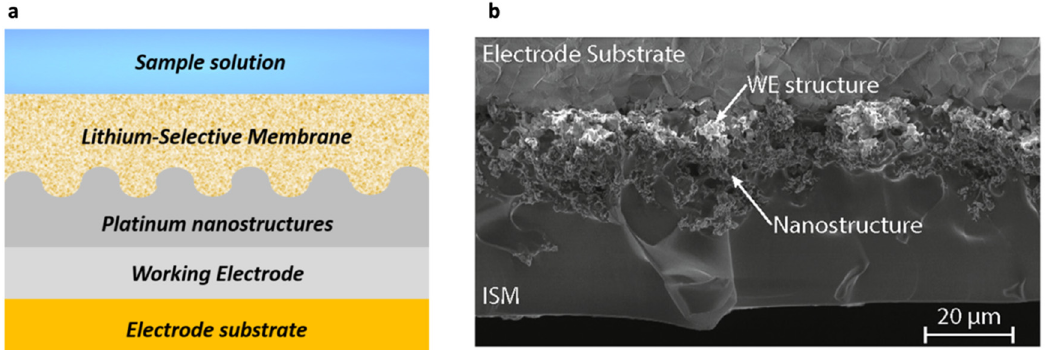
Figure 7. ( a ) The structure of the Li+-ISE-based sensing electrode on platinum nanostructured sol- id-contacts. ( b ) SEM cross-sectional view of a Li + ISE with platinum nanoflowers as SC (modified with permission from Criscuolo et al., Analytica Chimica Acta , 2018 [30]).